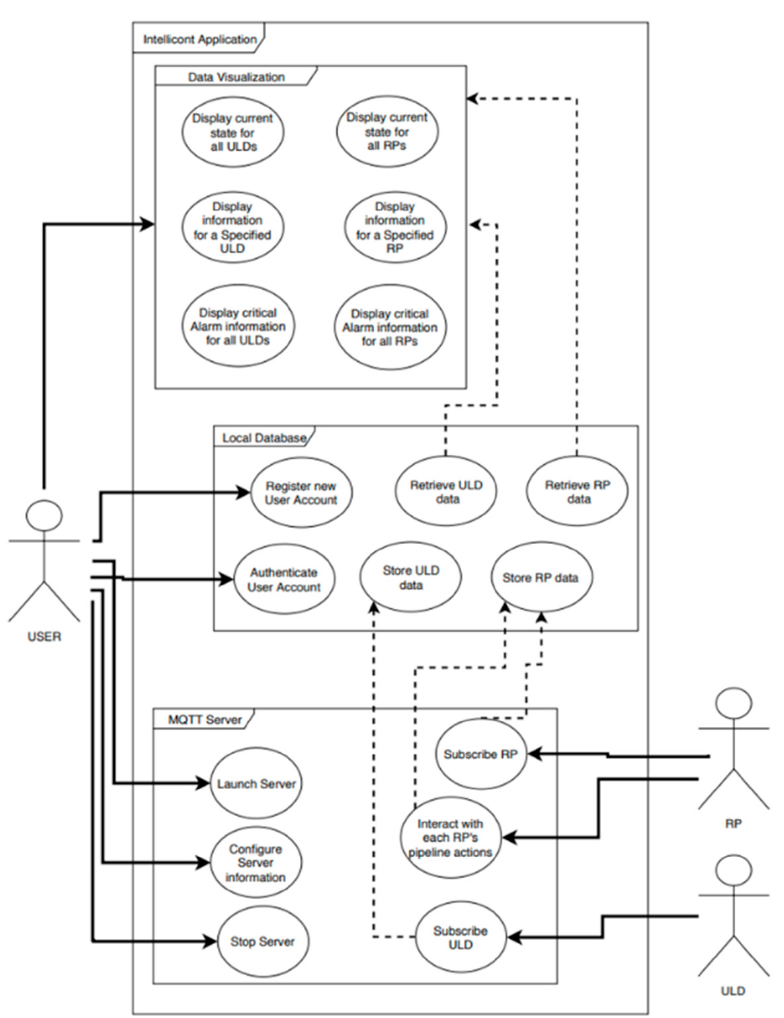
Figure 4. HMI application use cases illustration.